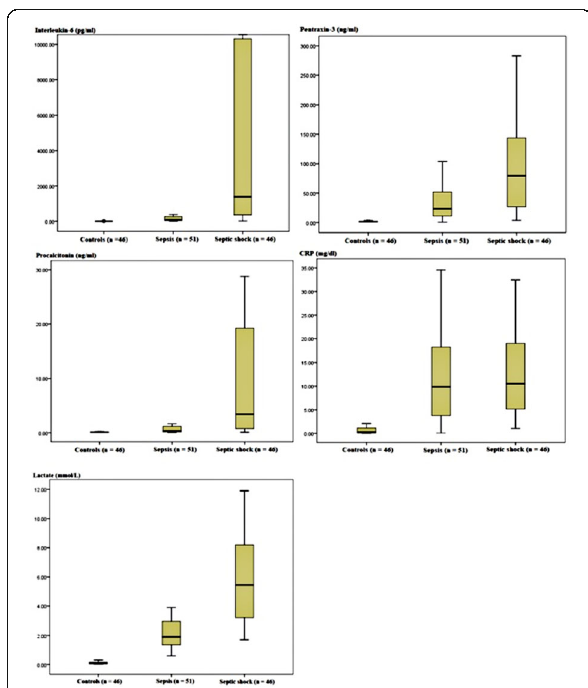
Fig. 1 (abstract P14). Interleukin-6, Pentraxin-3, Procalcitonin, CRP, and Lactate Levels in Patients with Sepsis and Septic Shock Diagnosed in the Emergency Department according to Sepsis-3 Definitions. CRP, C-reactive protein